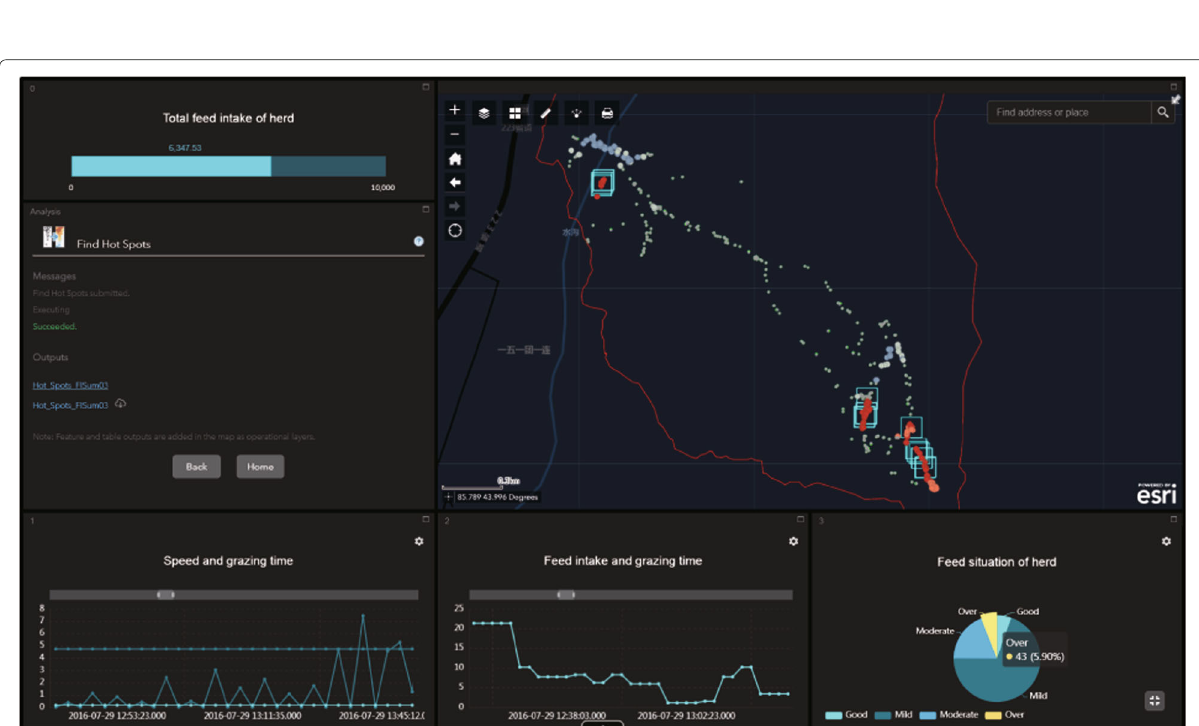
Fig. 10 The finding hot spots result diagram of the